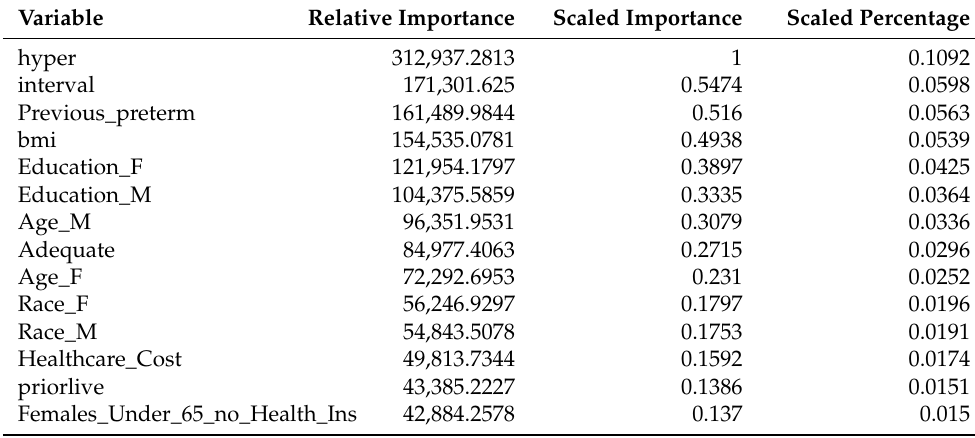
Table 5. The Top 15 Variables in Prediction of Preterm Birth.